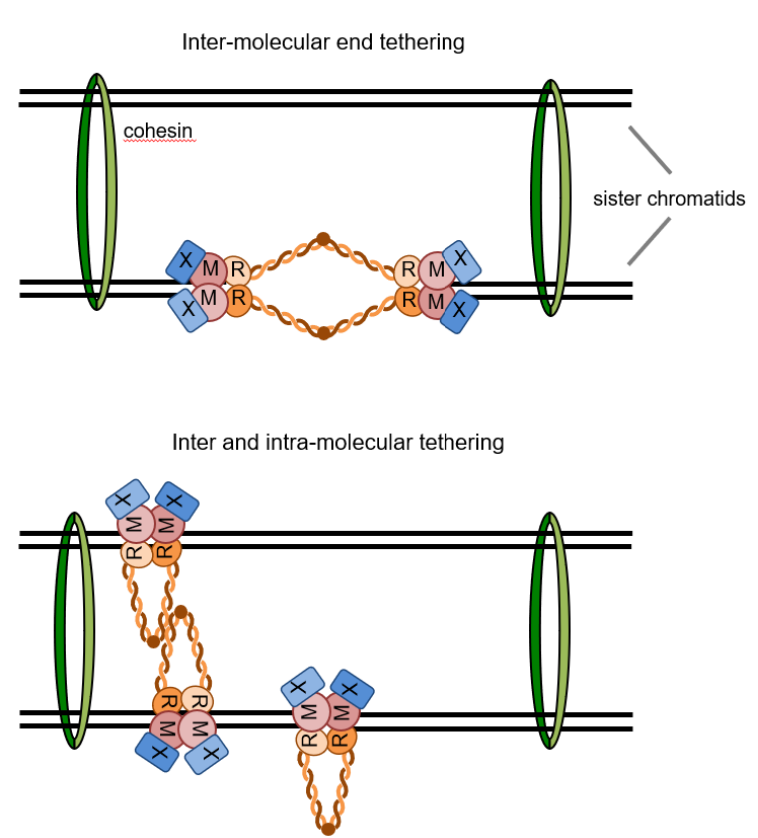
Figure 4. Potential end tethering configurations of the MRX complex. Assemblies of MRX at both DSB ends could bridge ends through intermolecular hook-mediated dimerization. Alternatively, intra-molecular dimerization of Rad50 could mediate bridging of DNA ends and oligomerization of the coiled-coils could facilitate sister chromatid interactions. In both cases, proximity to the sister chromatid is maintained through cohesin enrichment in the vicinity of DSBs.